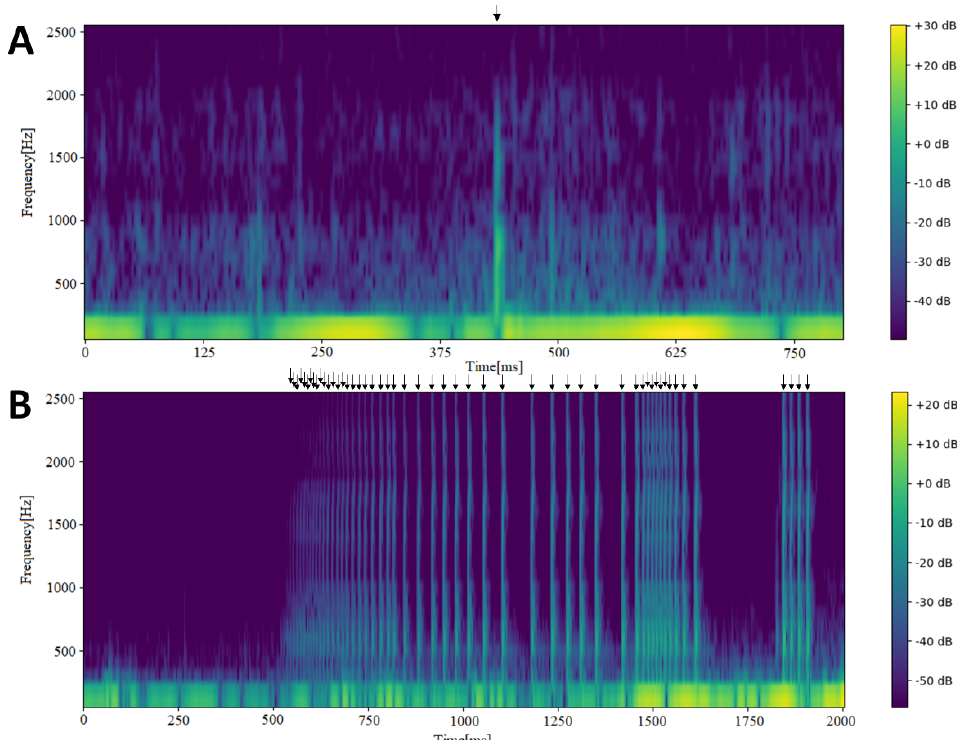
Figure 1. Spectrograms depicting bowel sounds recorded using a contact microphone in the right lower quadrant of the abdomen. ( A ) An individual short bowel sound is clearly discernible in the middle (~425 ms; indicated by the arrow at the top). The signal below 250 Hz is composed of venous hum and heart beats. ( B ) A series of over 50 bowel sounds (arrows) occurring in less than 1.5 s.